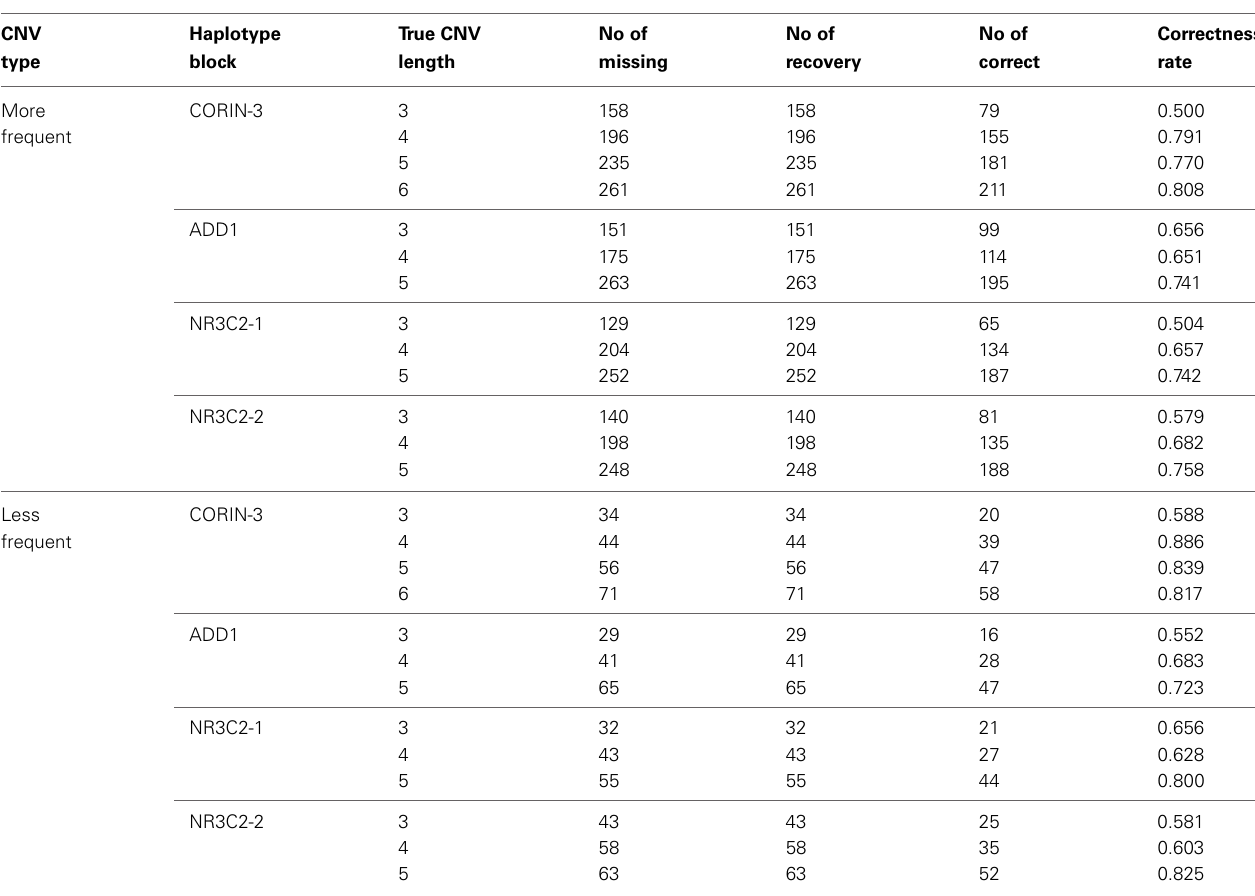
Table 4 | Missing recovery using haplotypes.